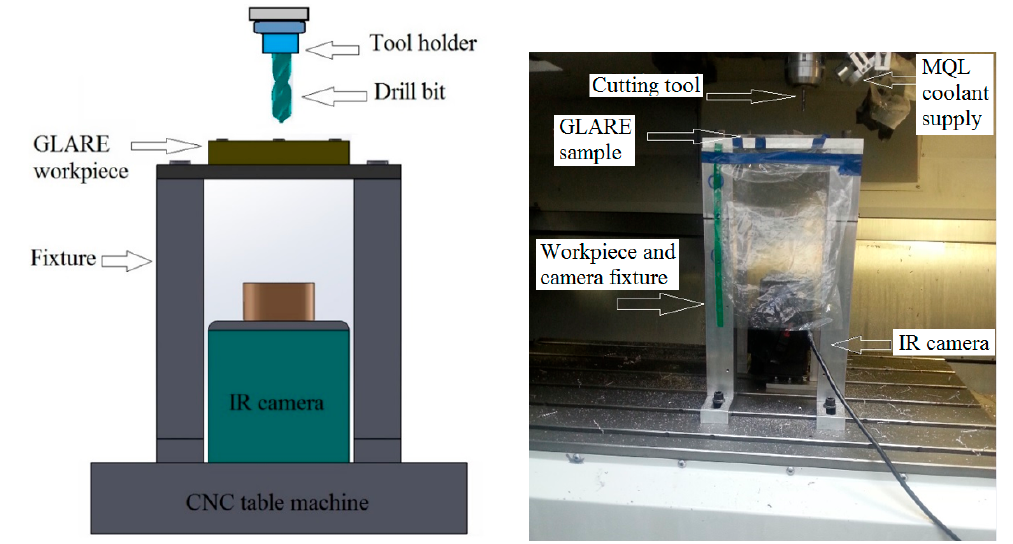
Figure 5. Details of the temperature measurement setup using the IR camera. Table 5. Cutting parameters used in drilling temperature measurements in dry and MQL